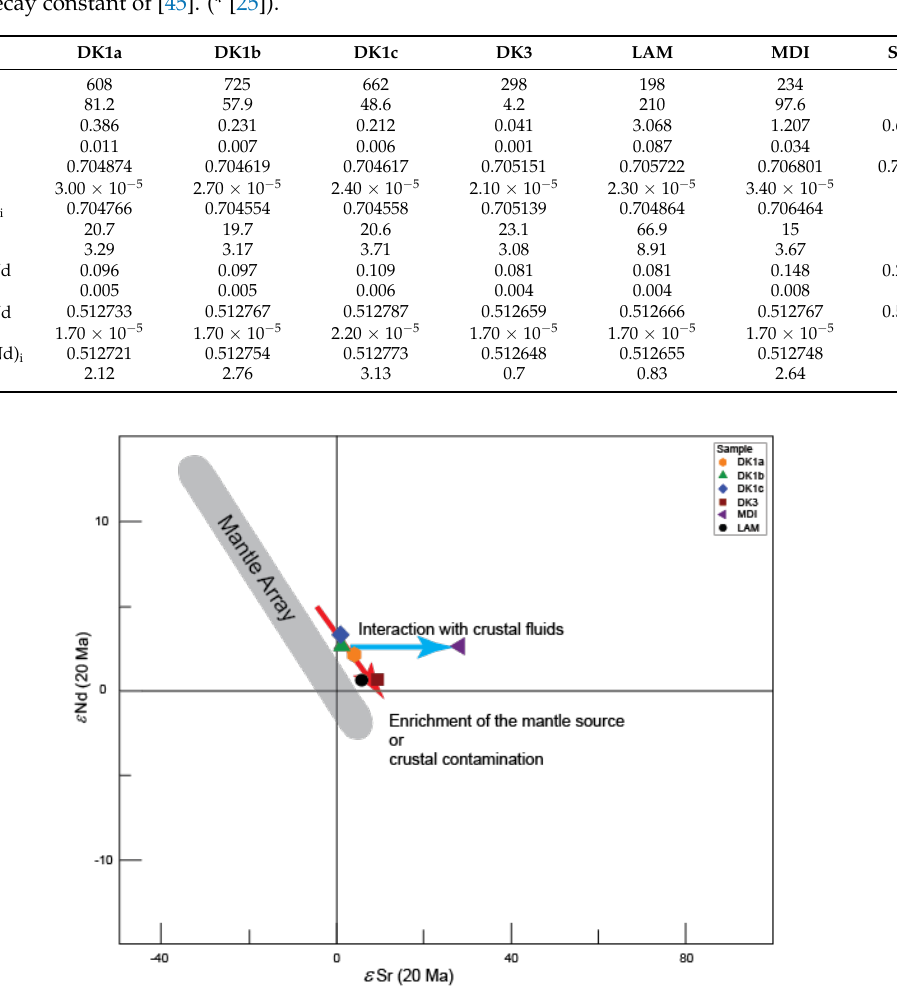
Figure 14. Plots of Sr–Nd isotopic compositions for the Sungun post-mineralization dykes. Initial values of εNdi vs. 87 Sr/ 86 Sri calculated for 20 Ma for the Oligo-miocene dykes [45]. Table 7. Results for Rb-Sr and Sm-Nd isotopic systems in samples of post-mineralization dykes from Sungun. Initial values were calculated for an age of 20 Ma, using the 147 Sm decay constant of and the 87 Rb decay constant of [45]. (* [25]). Sample